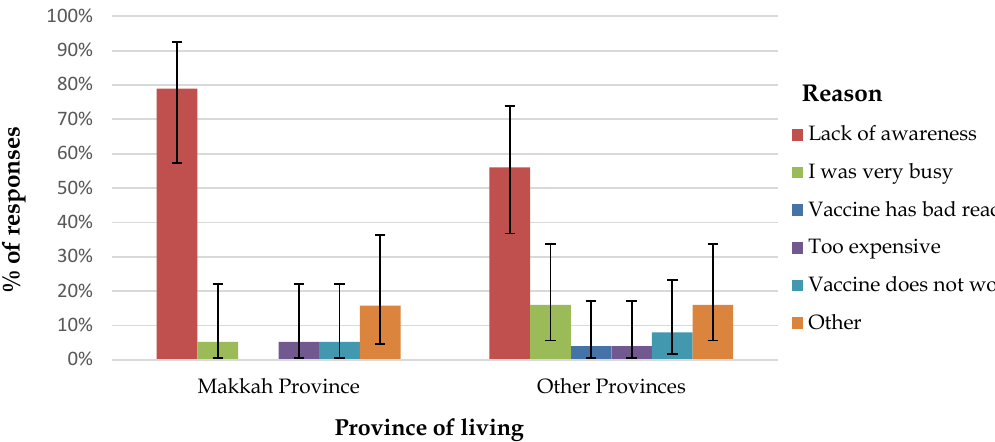
Figure 1. Reasons for non-receipt of meningococcal vaccine among unvaccinated domestic pilgrims: proportion of participants providing each reason with the 95% confidence interval for the point estimate.